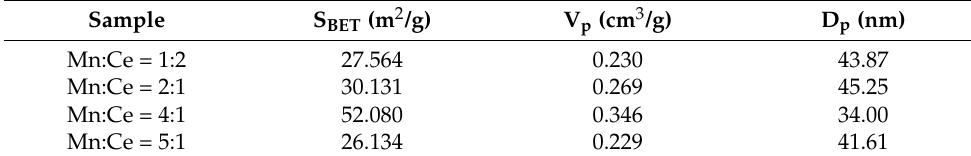
Table 2. Catalyst pore structure data for different activity group distribution ratios.